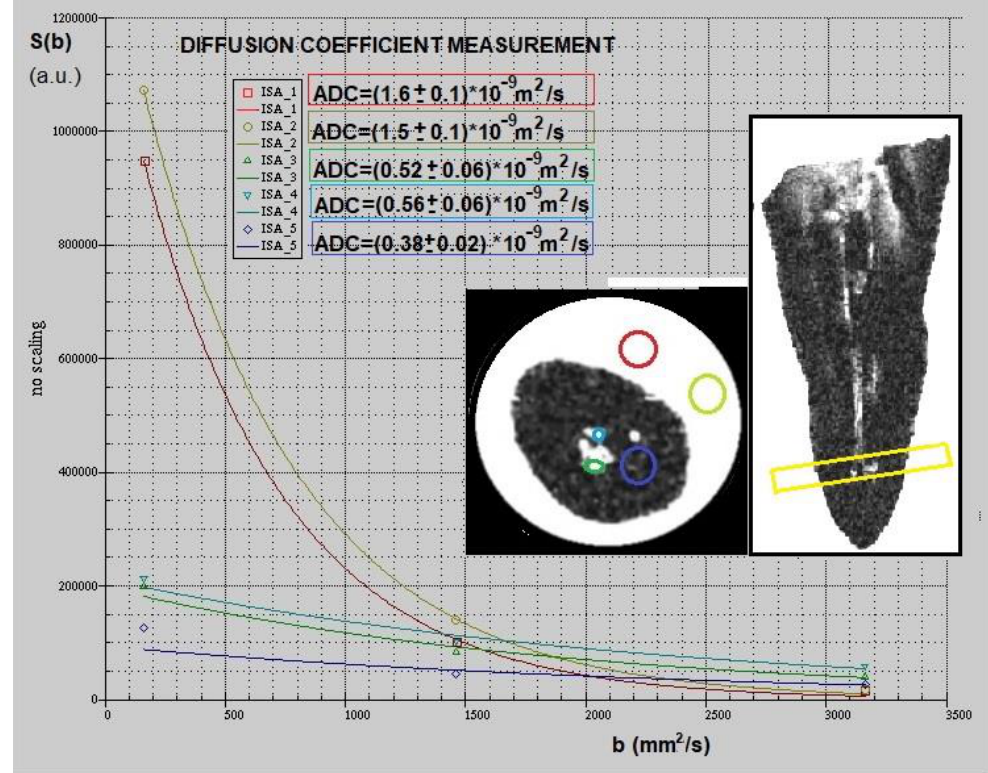
Figure 7. Diffusion coefficient weighted images of the tooth and fits function to experimental data from which ADC values were extracted and quantified in each region highlighted with different colors. The yellow slice in the parasagittal section represents the beginning of the apical third: in this specific case, this area is not sealed by Gutta-percha. In the axial image it is indeed possible to distinguish the terminal tip of the Gutta-percha cone (black circle between blue and light blue ROIs), the dentin (blue circle) and the aqueous infiltrate with some debris (light blue and green ROIs).